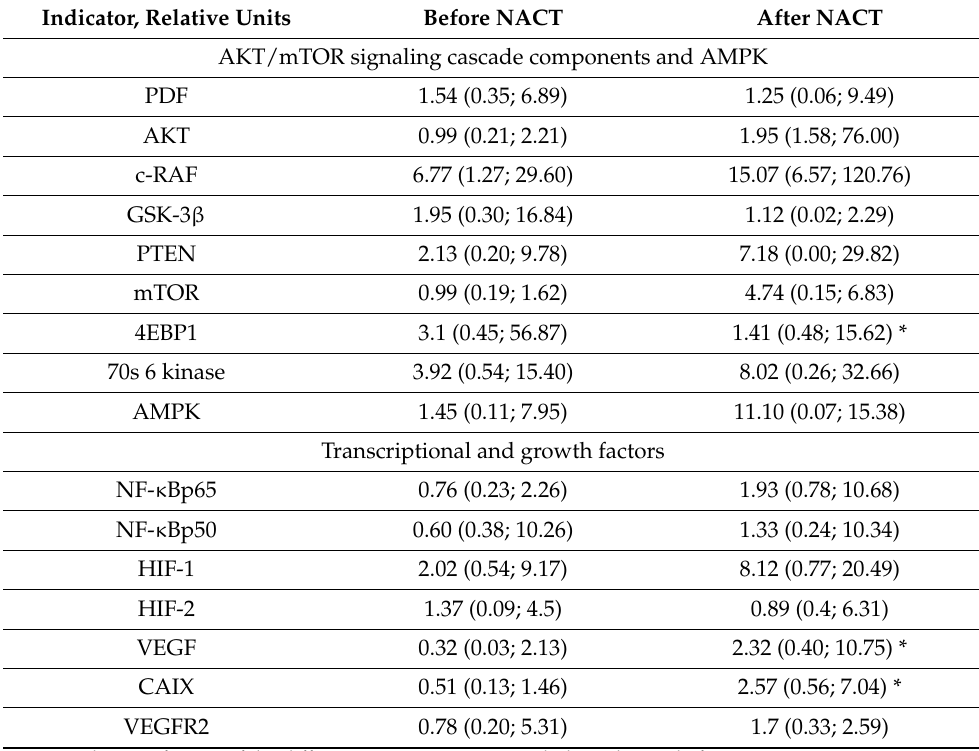
Table 4. Influence of neoadjuvant therapy on the expression of the AKT/mTOR signaling pathway components and AMPK in gastric tumors.